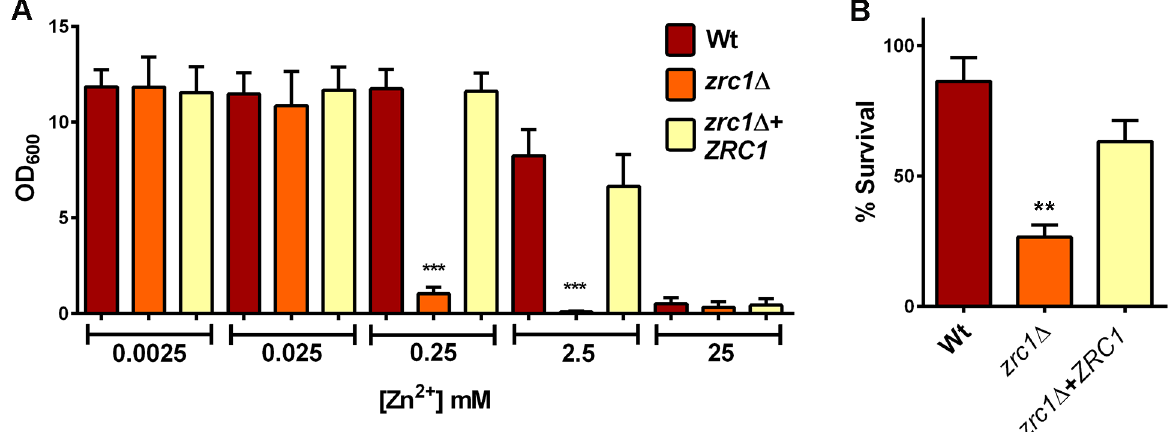
Fig 11. Zrc1 is essential for zinc detoxification. ( A ) Strains were cultured for 24 h in SD0 medium containing indicated zinc supplementation. Experiment performed at least three times in duplicate for zinc concentrations at 25 μM and above. (cid:3)(cid:3)(cid:3) indicates significant difference ( P < 0.001) compared to wild type and revertant, ANOVA. ( B ) Strains were precultured in SD0, challenged with 1 M ZnSO 4 for 3 h and viability assessed by measuring CFUs. (cid:3)(cid:3) indicates significant difference ( P < 0.01) compared to wild type and revertant, ANOVA. Experiment performed three times for wild type and zrc1 Δ and twice in duplicate for all three